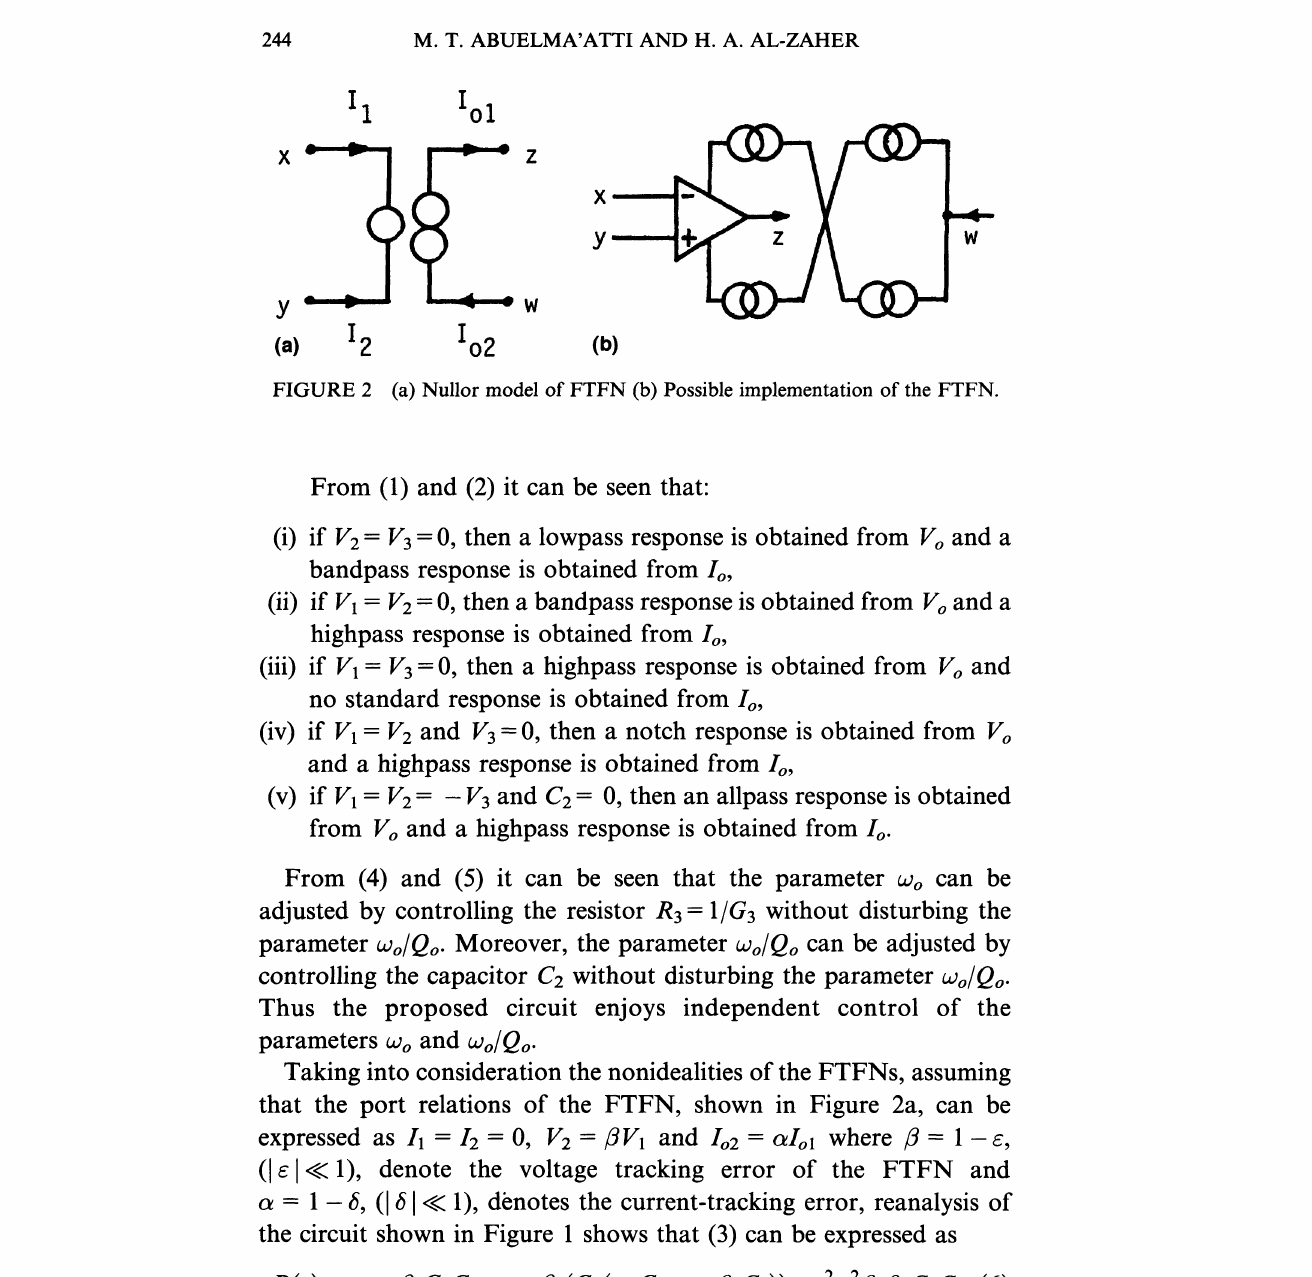
FIGURE 2 (a) Nullor model of FTFN (b) Possible implementation of the